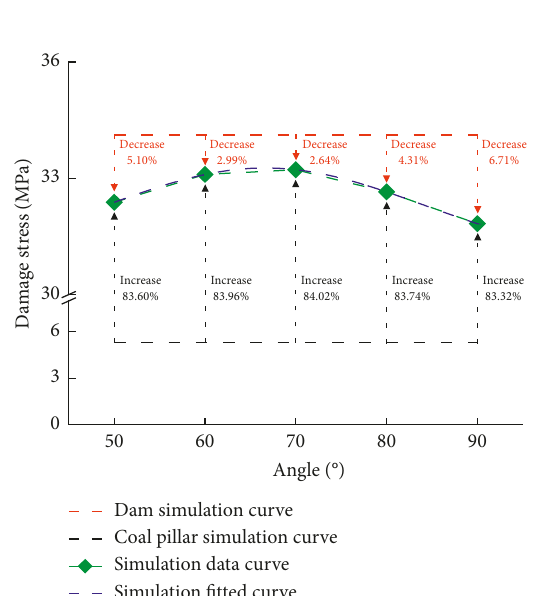
Figure 17: Relationship between angle and damage stress.